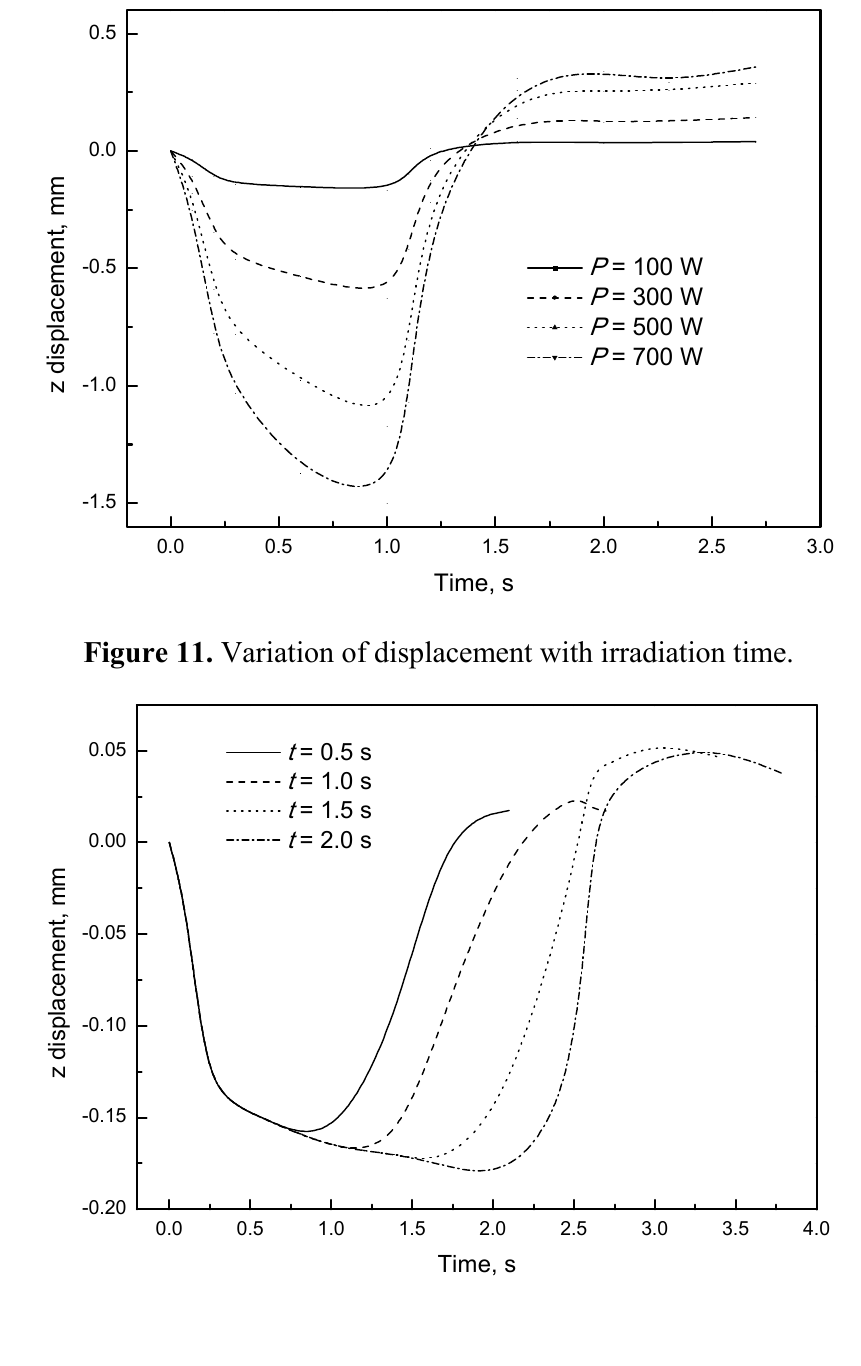
Figure 10. Variation of displacement with laser power.